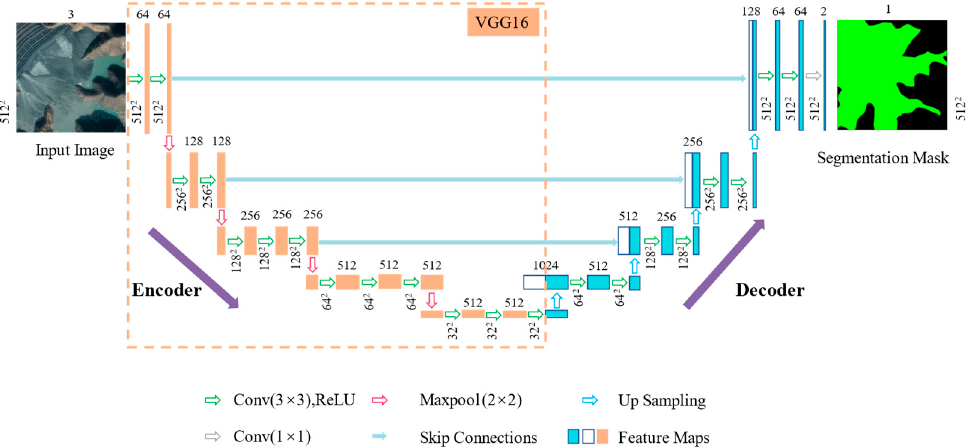
Figure 5. Network structure of the VGG16-UNet model. The VGG16 network is located on the left side of the U-shape, and the decoder is located on the right side. side of the U-shape, and the decoder is located on the right